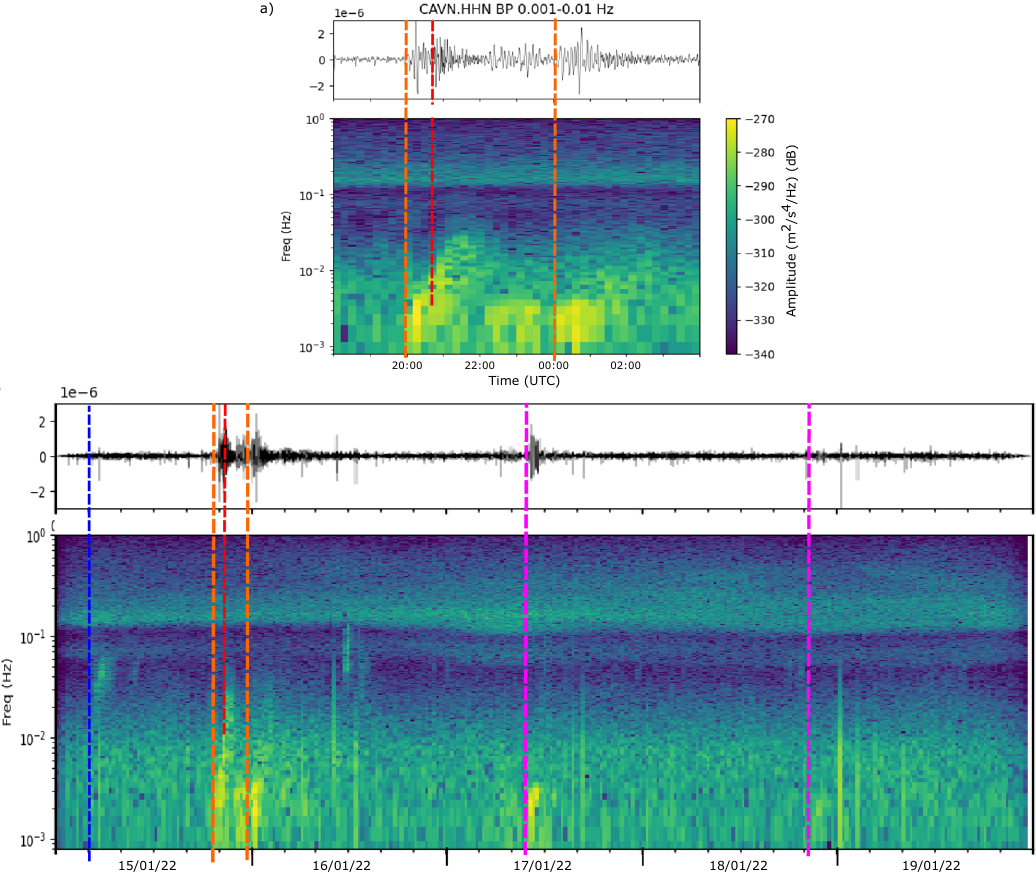
Fig. 2 Seismic signals related to the atmospheric wave recorded at station CA.CAVN (NE Iberia). a Arrival of the fi rst atmospheric waves. Orange lines show the arrival of the Lamb waves travelling along the short and long path of the great circle. Red dashed line shows the arrival of the dispersive wave. b Five days of seismic signal and spectrogram at the same station. Blue dashed line shows the arrival of the seismic waves. Orange and red dashed lines show the fi rst arrivals of the atmospheric waves. Purple lines shows the record of the atmospheric waves after successive circumambulations of the Earth. The instrument response has been removed and the seismic trace has been band-pass fi ltered between 1and 10 mHz. The data shown correspond to the N-S component. The spectrogram corresponds to the un fi ltered data and was calculated using a window length of